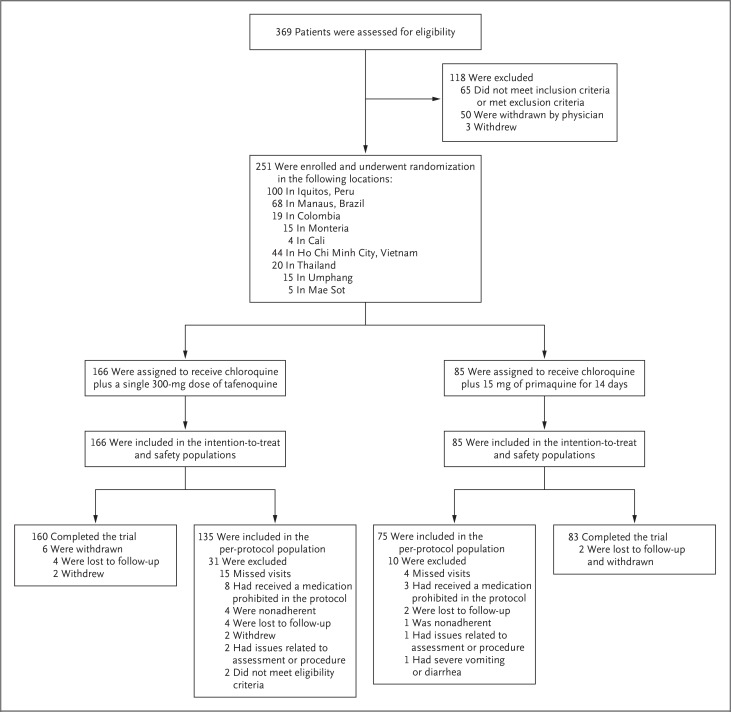
Enrollment, Randomization, and Trial Populations in the GATHER Trial.The safety population included all patients who underwent randomization and received at least one dose of a trial medication in a blinded manner. The intention-to-treat population was a subgroup of patients from the safety population who had microscopically confirmed Plasmodium vivax parasitemia. The per-protocol population was a subgroup of patients from the intention-to-treat population who had no major protocol violations. Patients may have had more than one reason for exclusion from the analysis populations. GATHER denotes Global Assessment of Tafenoquine Hemolytic Risk.